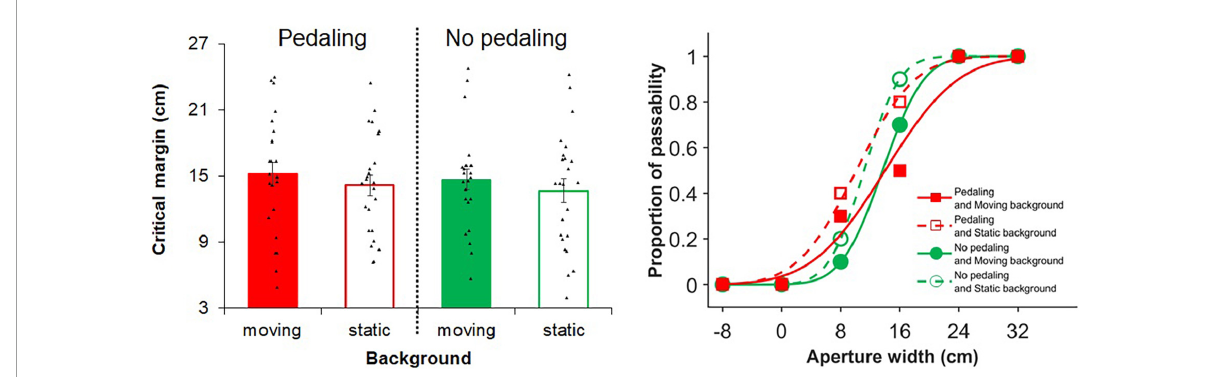
FIGURE3 Results of experiment 2. In the left panel, each bar graph represents an average of the critical margin across participants in each self-motion condition. The critical margin was 50% threshold when fitting the cumulative gaussian distribution functions using aperture width conditions in each self-motion condition. Dots indicate individual critical margins in each of self-motion conditions. In the right panel, passable rate of a representative participant in each aperture width condition was plotted and fitted with the cumulative gaussian distribution functions in each self-motion condition. Larger positive values indicate larger margin expansion. Error bars show standard